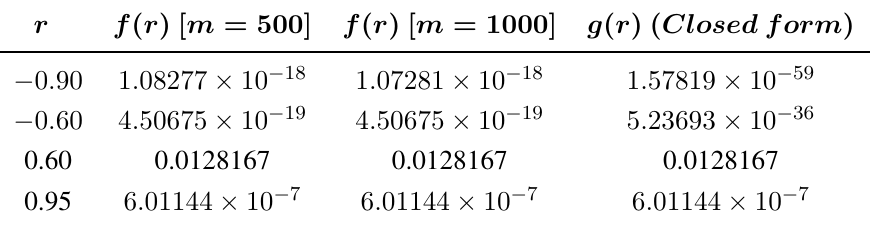
Table 2. PDF of R as evaluated from f ( r ) truncated to m terms and g ( r )